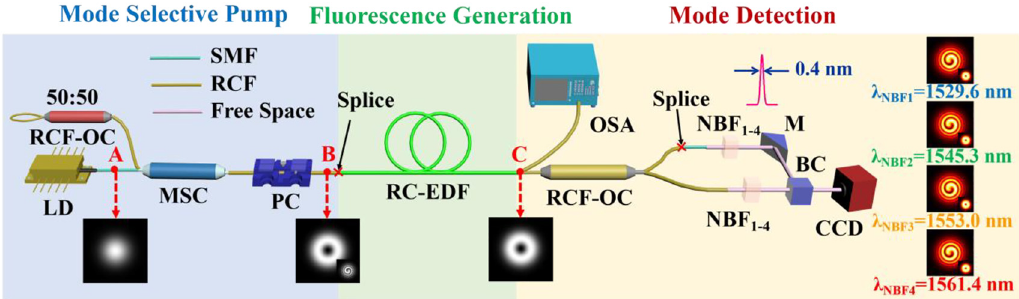
Figure 7: Schematic diagram of an all-fiber system of the OAM mode fluorescence emission, spectral analysis and mode detection. LD: laser diode; OC: optical coupler; MSC: mode selective coupler; PC: Polarization controller; RC-EDF: ring-core erbium-doped fiber; NBF: narrow-band filter; M: mirror; BC: beam combiner. CCD: charge-coupled device. NBFs with a band width of 0.4 nm are employed to select the narrow-band beam at the wavelengths of 1529.6, 1543.3, 1553.0, and 1561.4 nm.